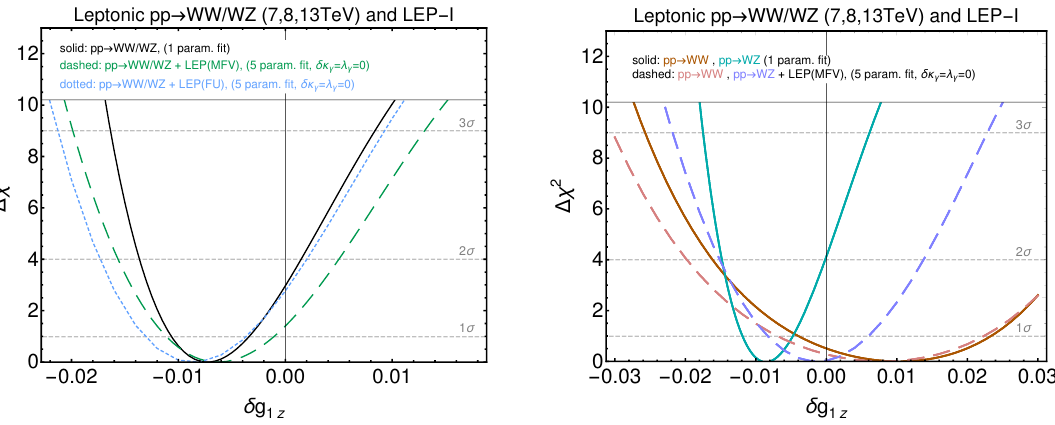
Figure 4 . 95% CL regions for the aTGCs. The red curves show the bounds from a three parameter (cid:12)t of the current LHC diboson data, imposing (cid:14)V (cid:22) qq = 0 and pro(cid:12)ling over the aTGC not shown on the plots. The green and blue curves show the bounds from a seven parameter global (cid:12)t using the current LHC diboson data as well as the LEP-1 data under the MFV and FU assumptions respectively; the parameters not shown on the plots are pro(cid:12)led over.